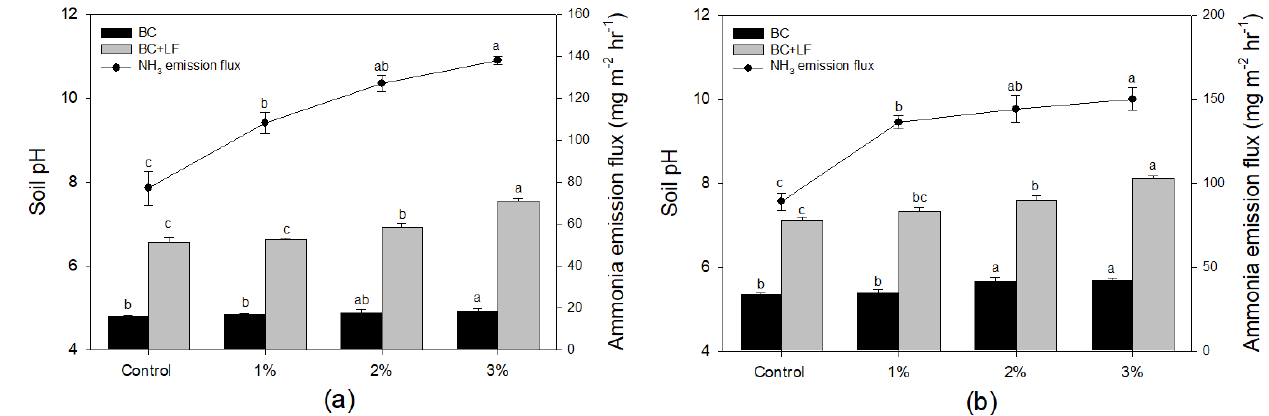
Figure 3. Effect of biochar (BC) and liquid fertilizer application (LF) on soil pH and ammonia emission rate for two soil. Initial pH of soil ( a ) and soil ( b ) are 4.80 and 5.34, respectively. Different letters indicate significant differences according to Tukey’s test. Bar graph indicates soil pH (left y-axis) and dot graph indicates ammonia emission flux (right y-axis).